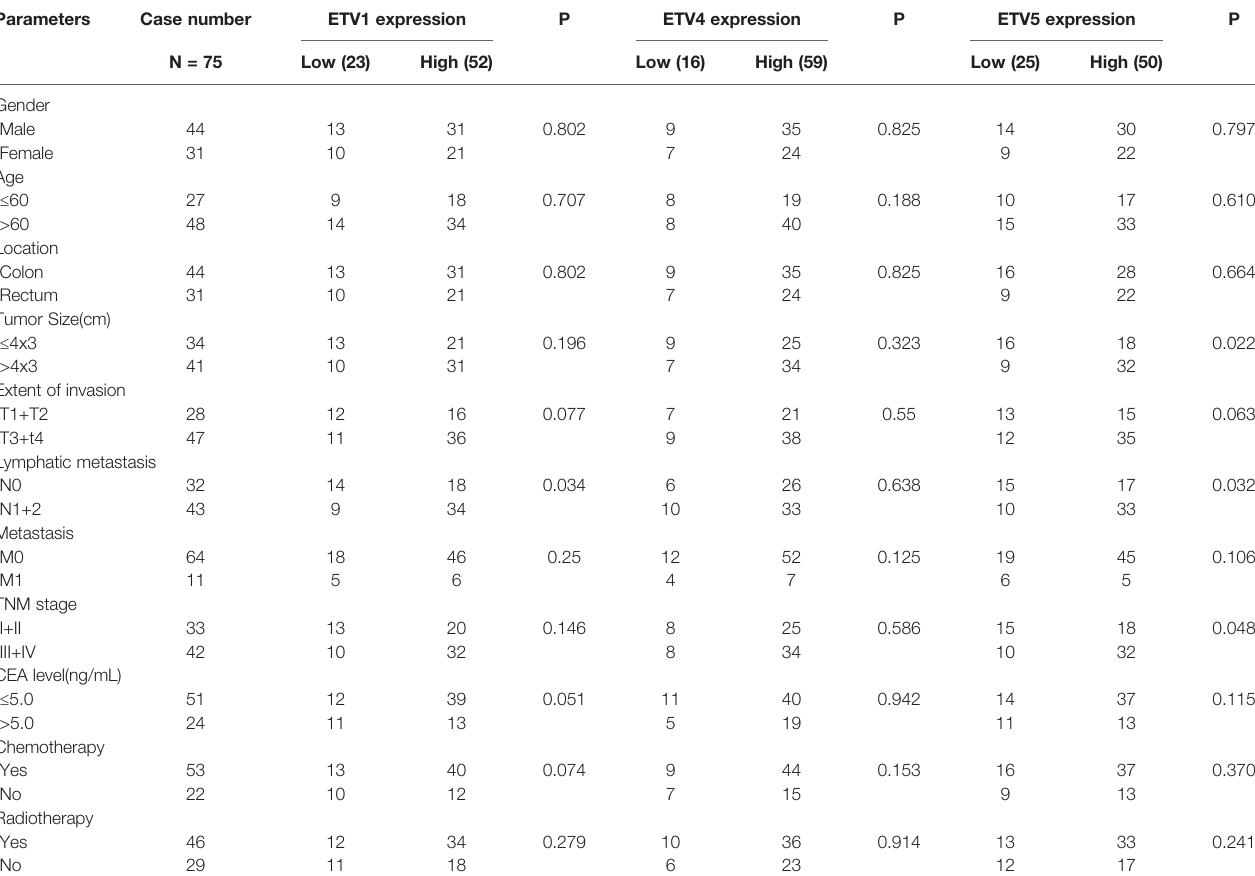
TABLE 1 | Basic clinical variables of the 75 CRC patients.